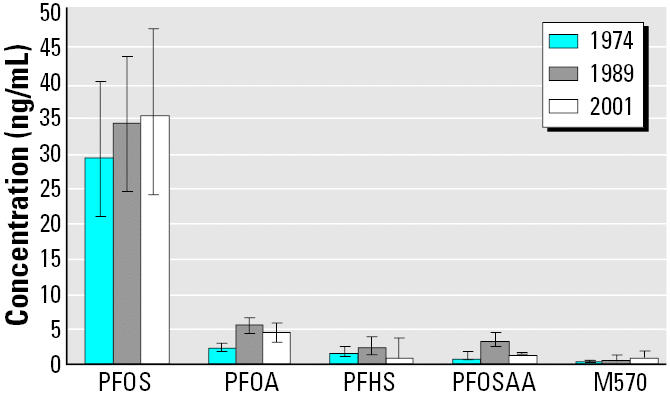
Median fluorochemical concentrations and IQRs for blood samples collected in Washington County, Maryland, from adults living in proximity in 1974 (n = 178 serum samples) and 1989 (n = 178 plasma samples) and in the county in 2001 (n = 108 serum samples; Olsen et al. 2003c).